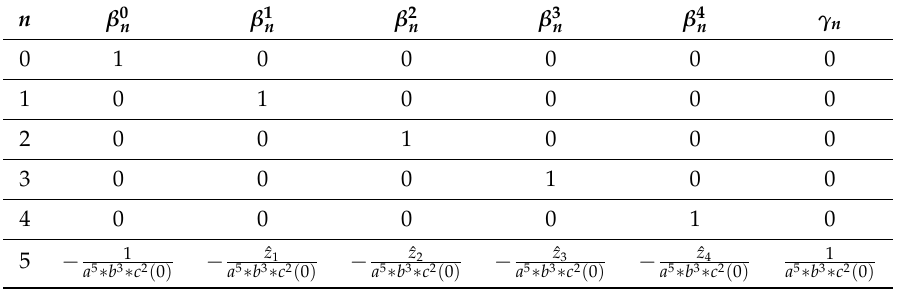
Table 2. Initial values of sequences β 0 n , β 1 n , β 2 n , β 3 n , β 4 n and γ n